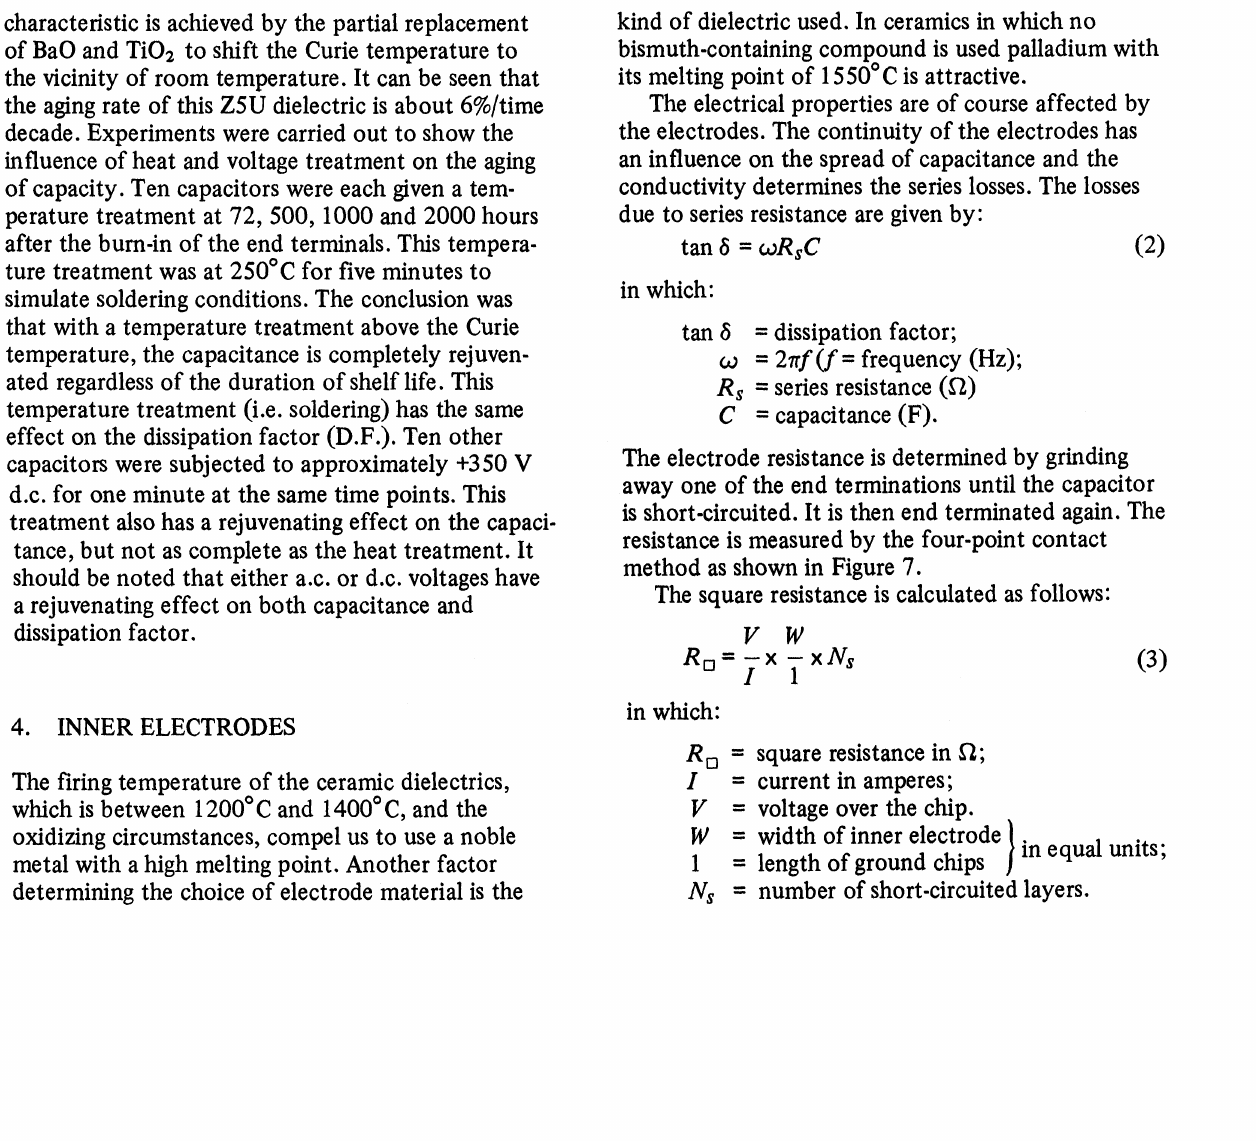
76- 100 1000 lO Time in hrs FIGURE 6 Capacitance vs. time of a material with the Z5U characteristic.